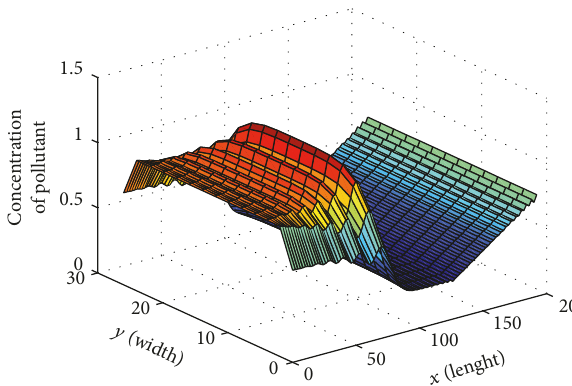
Figure 21: Compare the concentration of air pollutant where 𝑅 , 𝑅 𝑅 1 2 , and 3 are difference of three